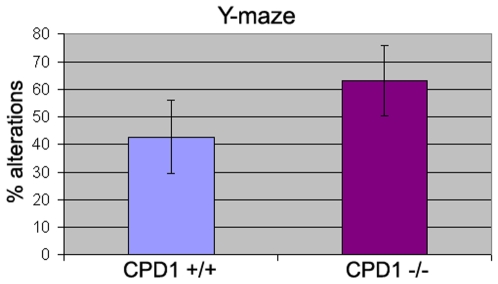
CPD1 null mice do not depict any memory related behavioral changes tested by Y maze.4 month old CPD1 +/+ (n = 3) and CPD1−/− (n = 8) mice were tested on Y maze for spontaneous alterations to enter arms of Y maze. Mice were tested for 5 minutes or 22 entries (whichever came first) in arms of a Y maze. No significant difference in % of alterations were observed (p>0.05).